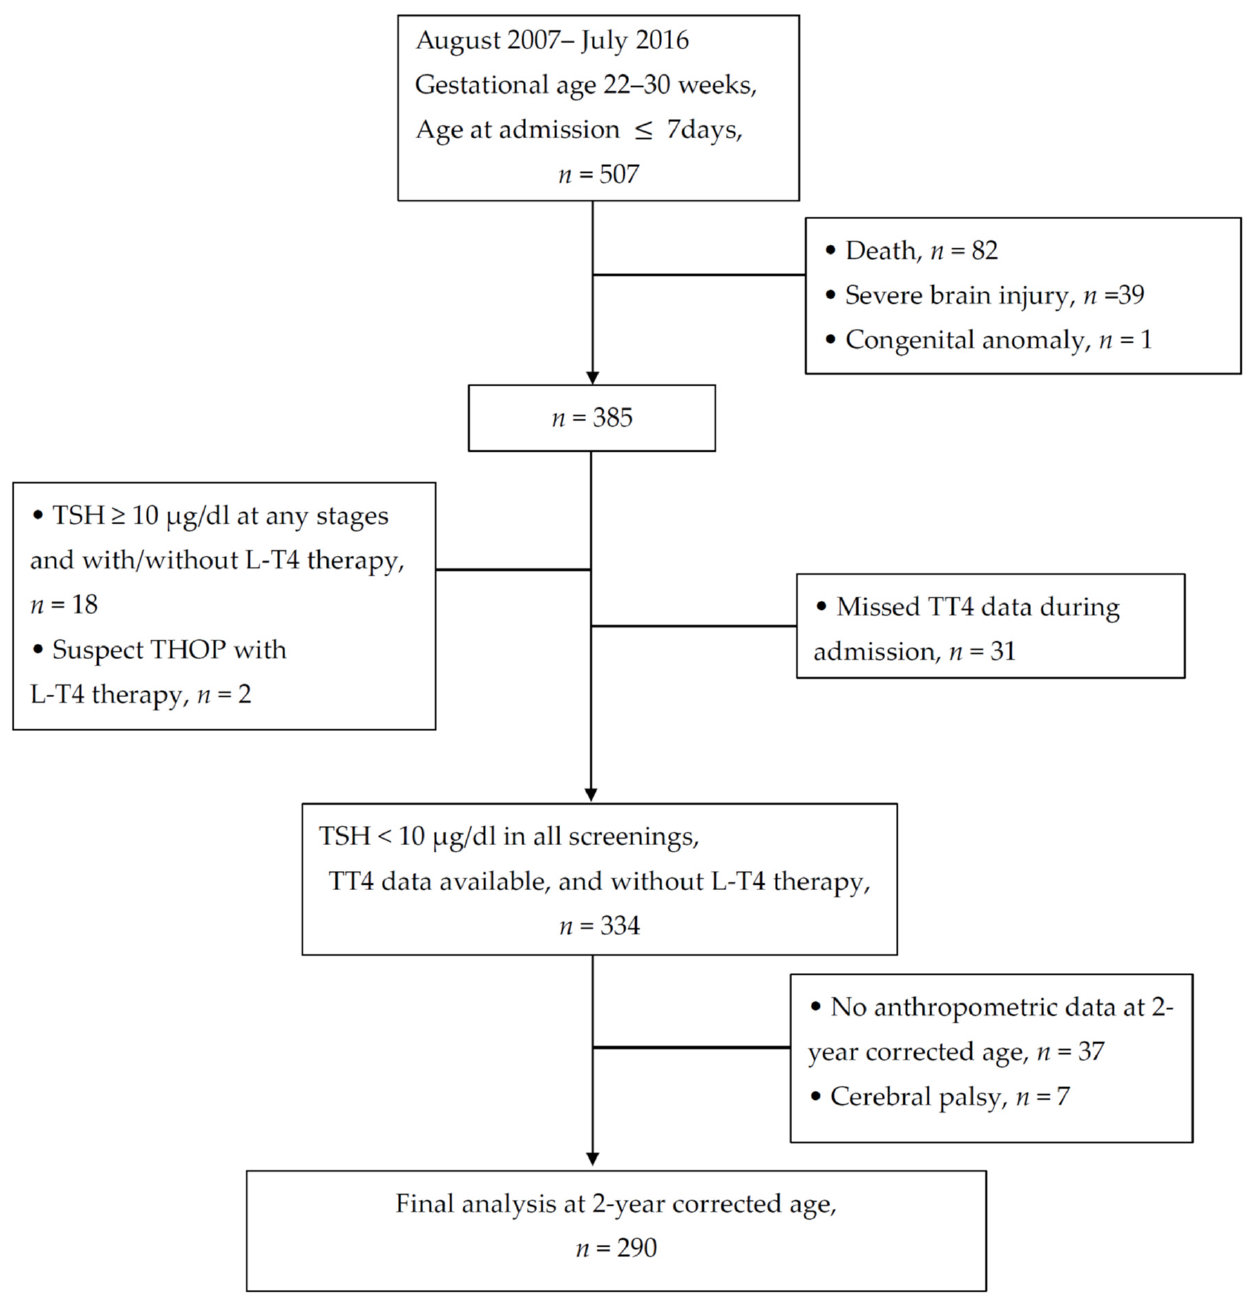
Figure 2. Flow chart of patient enrollment. L-T4: levothyroxine; THOP: transient hypothyroidism of prematurity; TT4: total serum thyroxine; TSH: thyroid stimulation hormone.